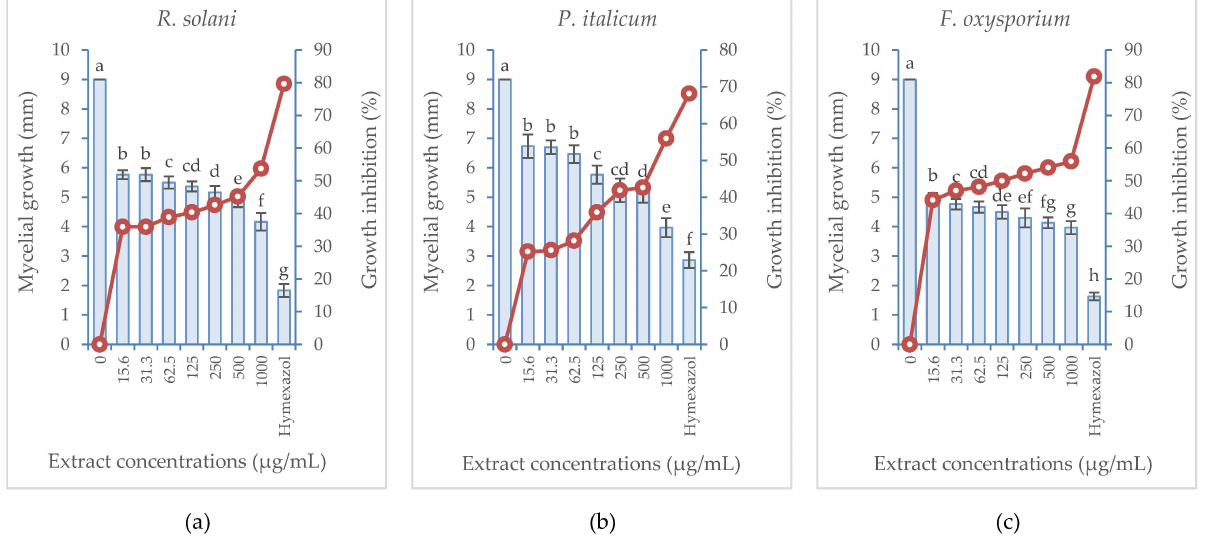
Figure 4. Mycelial growth (vertical bars on primary axis) and growth inhibition percentage (line on secondary axis) of three fungal species in response to the treatment with B. aegyptiaca methanolic fruit extract compared with hymexazol at 1000 µ g/mL: ( a ) Rhizoctonia solani , ( b ) Penicillium italicum , ( c ) Fusarium oxysporium . Values are represented as the mean ( n = 4) ± SD indicated by the vertical